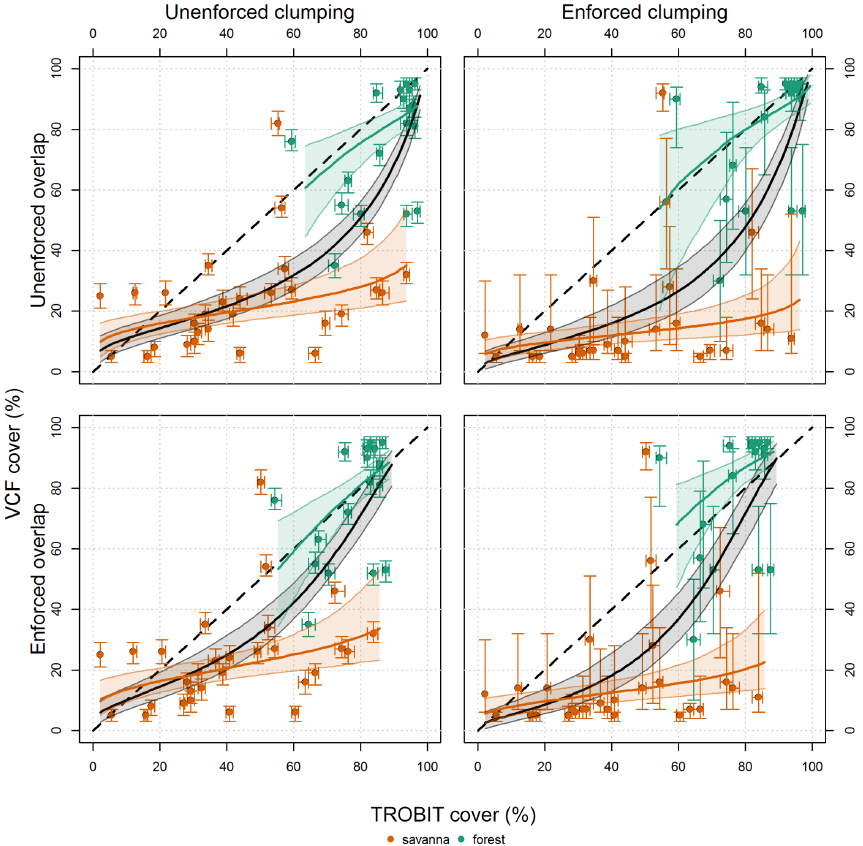
Figure 4. MODIS VCF percent tree cover versus percent tree cover from TROBIT field data, taking into account uncertainties associated with tree cover spatial distributions within a MODIS pixel and/or field site. The four combinations are the following: (1) no overlap and no clumping, where tree canopies are randomly distributed within both the pixel and site; (2) no overlap and maximum clumping, where tree canopies are clustered in one area of the pixel and randomly distributed throughout the field site; (3) with overlap and no clumping, where tree canopies are randomly distributed within the pixel but overlap substantially within the field site; and (4) with overlap and maximum clumping, where tree canopies are clustered to one side within the pixel and overlap substantially within the site. The bolded dashed line in black shows the 1:1 relationship. The solid lines represent the median of the respective regressions (green for forest, orange for savanna, and black for forest and savanna combined), and the thin lines represent the 5% and 95% confidence interval of their respective regression lines. The vertical error bars represent uncertainty introduced by clumping; the horizontal error bars represent the uncertainty introduced by